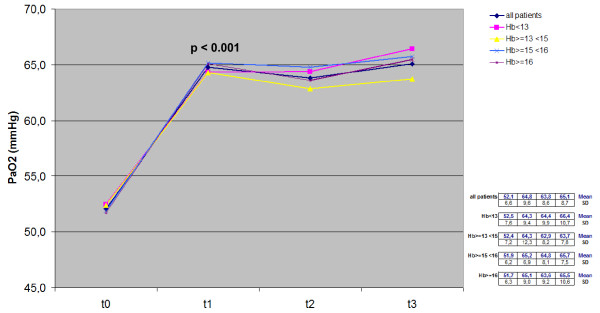
Time course of PaO2values in the whole cohort and in each subgroup:ttest between t0and t1. Hb, hemoglobin; PaO2, partial pressure of arterial oxygen.